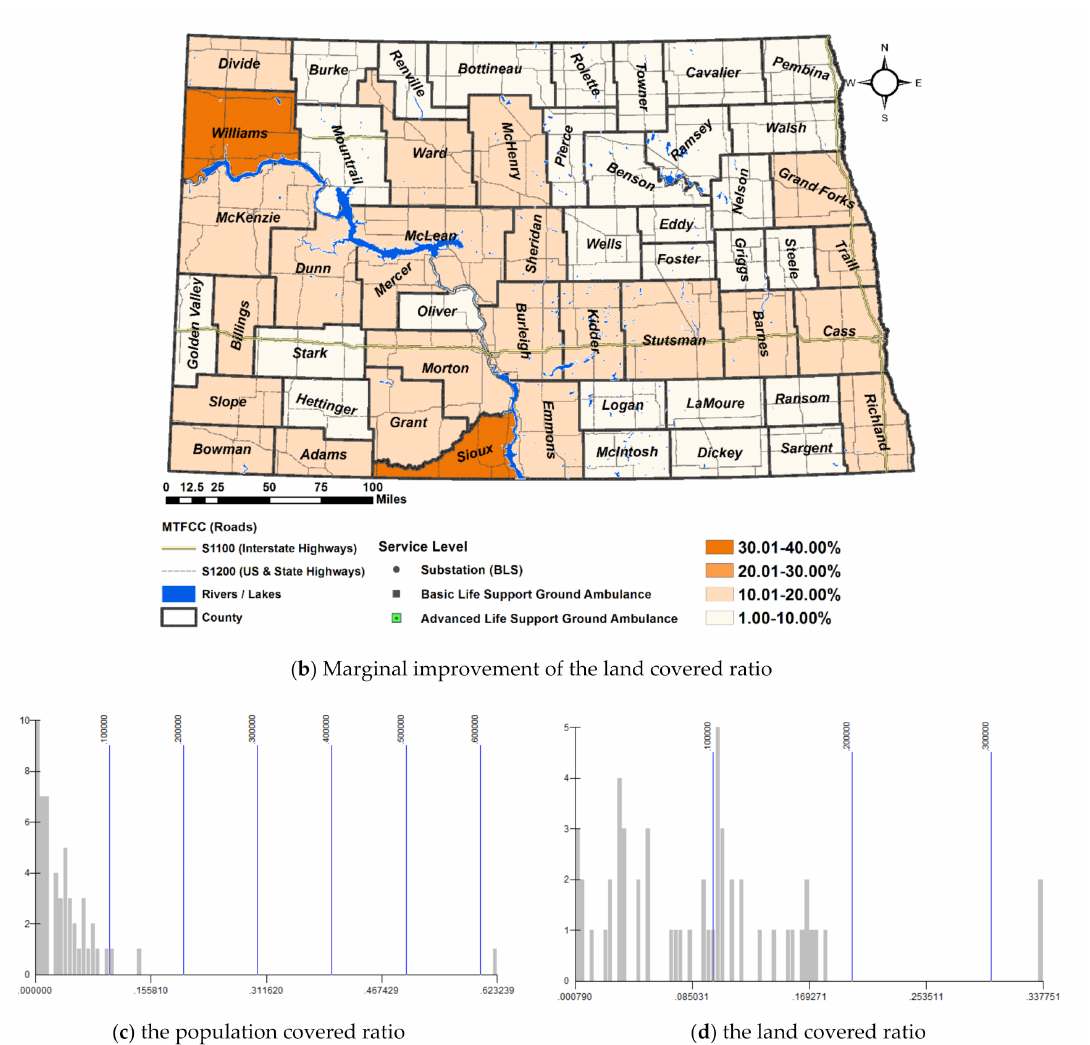
Figure 7. Improvement of Scenario 4 compared to Scenario 1: ( a ) the marginal improvement of population covered ratio, ( b ) the marginal improvement of the land covered ratio, ( c ) the distribution of population covered ratio, ( d ) the distribution of land covered